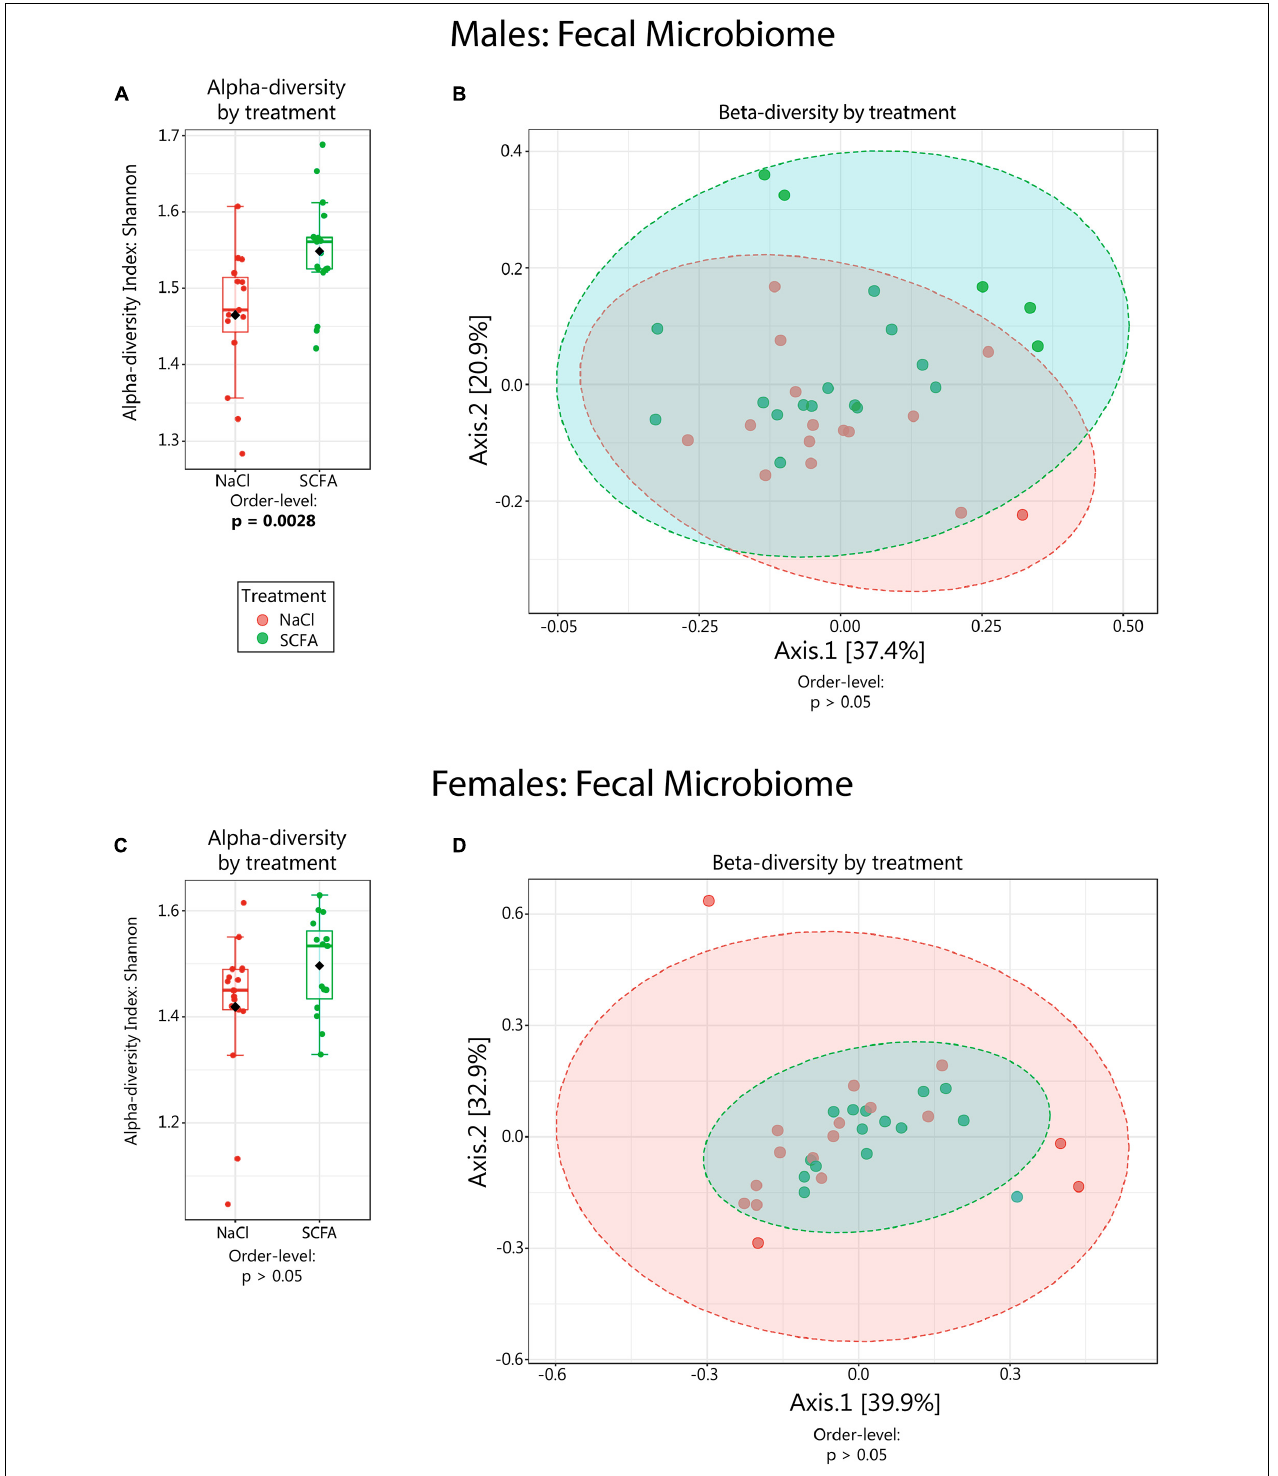
FIGURE 2 | Microbiome alpha- and beta-diversity as a function of short chain fatty acid (SCFA) treatment. Alpha-diversity (Shannon H index) data are depicted in boxplots (A,C) . Beta-diversity analyses are visualized in PCoA plots (B,D) . Statistical significance for the findings is indicated below each graph. Ellipses in (B,D) represent 95% confidence intervals. For male mice (B) R 2 = 0.035 and for female mice (D) R 2 = 0.023. Beta-diversity was also analyzed using PERMDISP, which had no significant p -values except in females at the species level ( p = 0.027), indicating that there was generally no difference in dispersion between SCFA vs saline treated